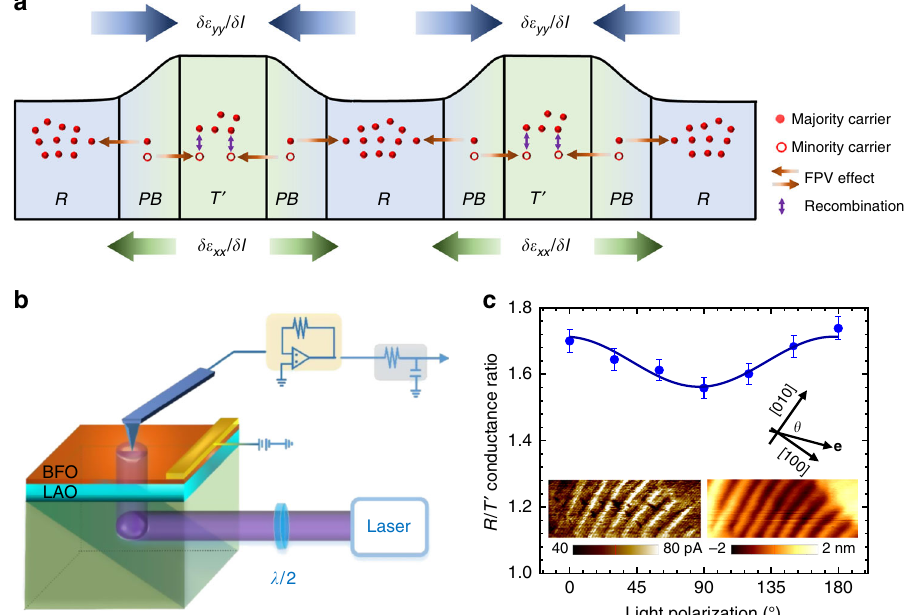
Fig. 4 Flexo-photovoltaic effect and light polarization resolved photocurrent mapping. a Schematic showing the electronic process happening at the morphotropic phase boundary. The abbreviation FPV refers the fl exo-photovoltaic effect. The number of the red dots denotes the resultant density of nonequilibrium carriers that determines the local photoconduction. b Schematic showing the illumination geometry. c Light polarization dependent photoconduction ratio between R - and T ′ -phases. The solid curve is the fi t of the experimental data with Eq. 1. Inset of ( b ) shows an example of photocurrent mapping with light polarization angle of 150° (left) and its corresponding topography (right). The error bars indicate the standard deviations of photo-conductance ratio between morphotropic phases mapped in a 2 × 0.4 μ m 2